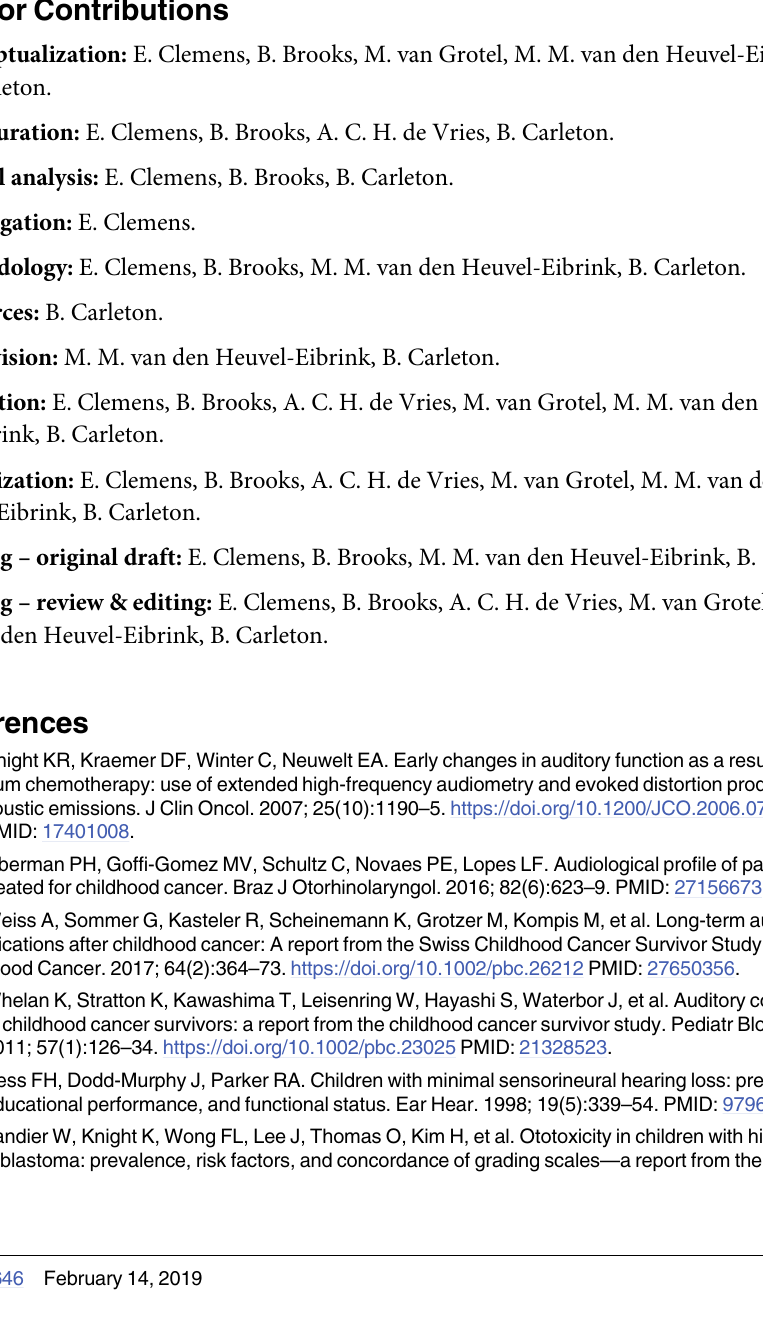
S1 Fig. U.S. National Cancer Institute Common Technology Criteria for Adverse Events